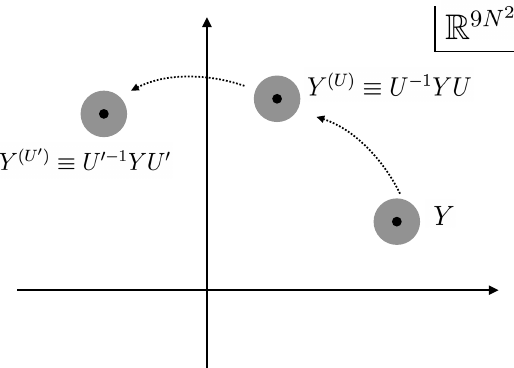
Figure 1 . Wave packets in the coordinate space R 9 N 2 . Black points are the centers of wave packets ( Y , Y ( U ) and Y ( U 0 ) ), and gray disks are the wave packets (more precisely, the regions where the wave functions are not vanishingly small). Under the gauge transformation, the center of the wave packet moves as Y → Y ( U ) = U − 1 Y U , but the shape of the wave packet does not change. The center of the wave packet gives ‘slow modes’ that describe the geometry consisting of D-branes and strings.